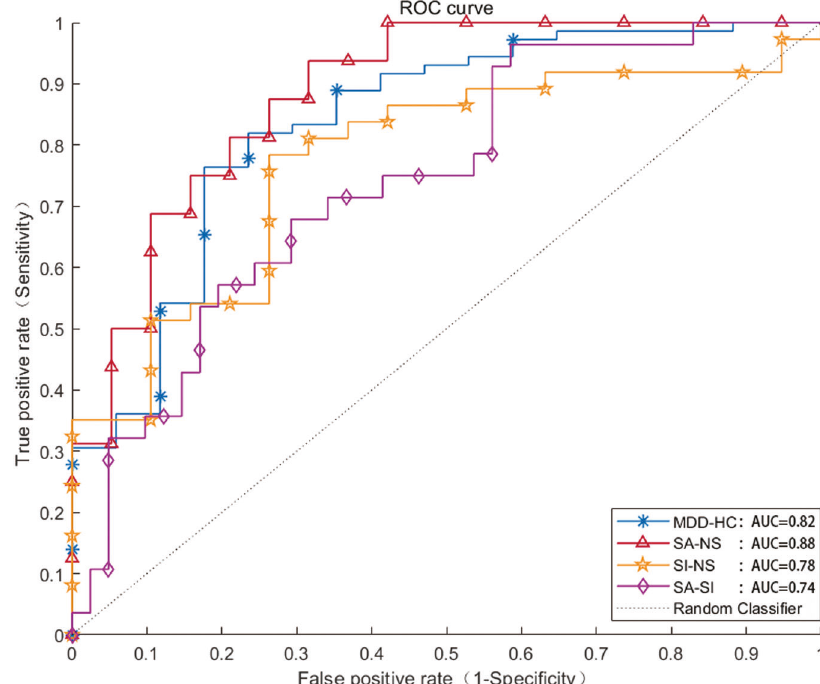
Fig. 4 ROC of the best classi fi ers between groups. AUC area under the curve, MDD major depressive disorder, SA suicide attempter, SI suicide ideation, NS individuals had neither SA nor SI, HCs healthy